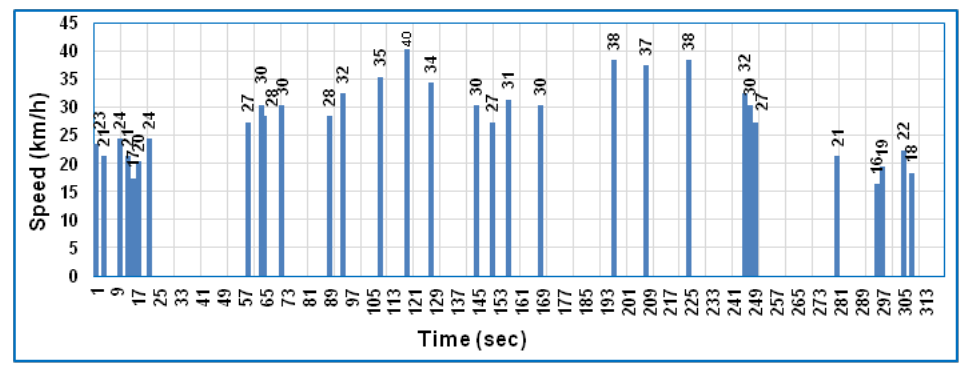
Figure 4. The bike speed in the case of applying the RCD